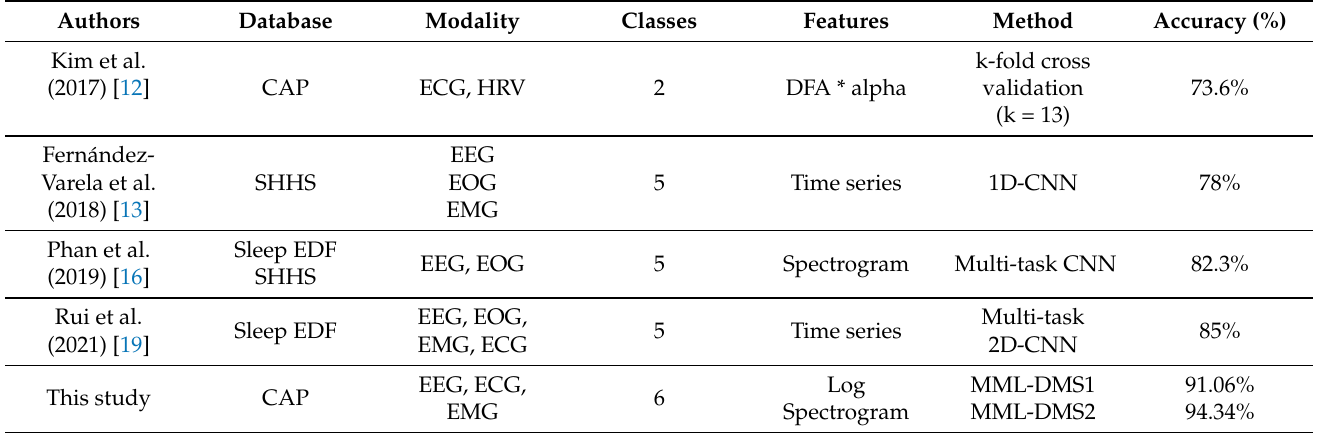
Table 7. A comparison with related multimodal sleep stage classification studies.